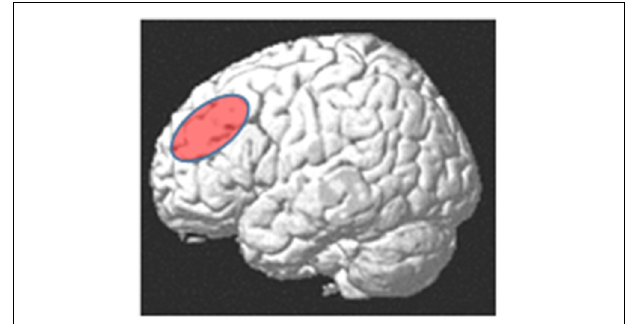
FIGURE 1 | Approximate anatomical location of the dorsolateral prefrontal cortex